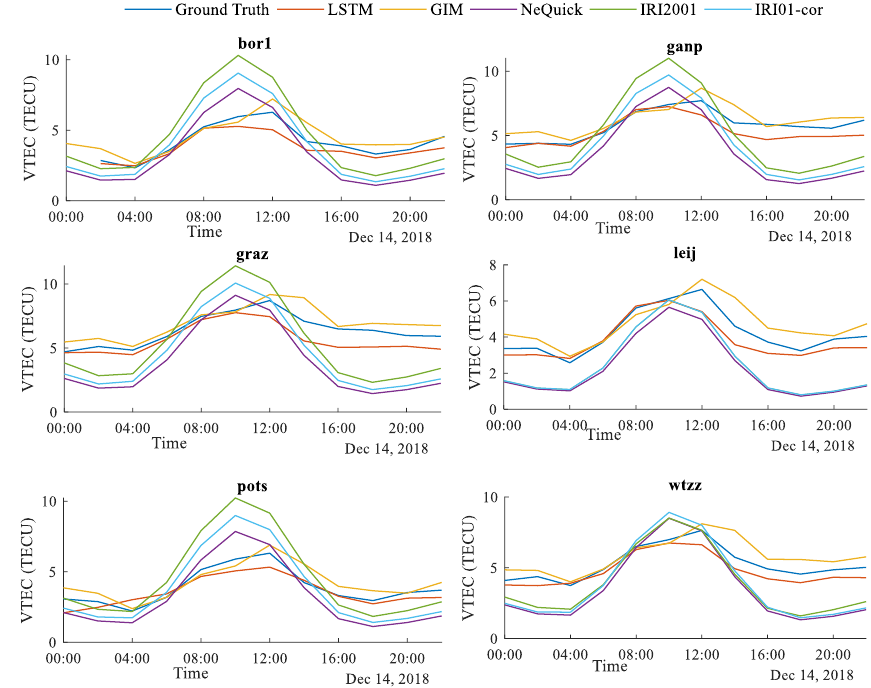
Figure 8. Comparison between VTEC (TECU) LSTM predictions (PRD), estimated GPS ionospheric VTEC values (GRD) and the VTEC models (GIM, NeQuick, IRI2001 and IRI01-cor).